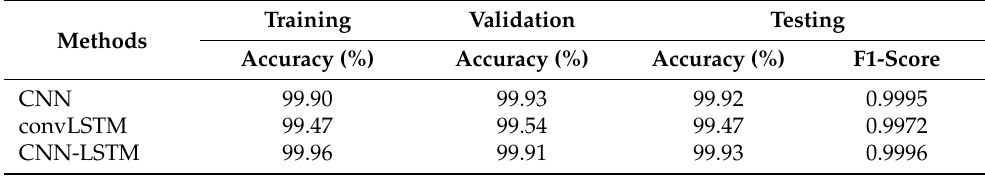
Table 10. Recapitulation of test results for comparing deep learning methods.